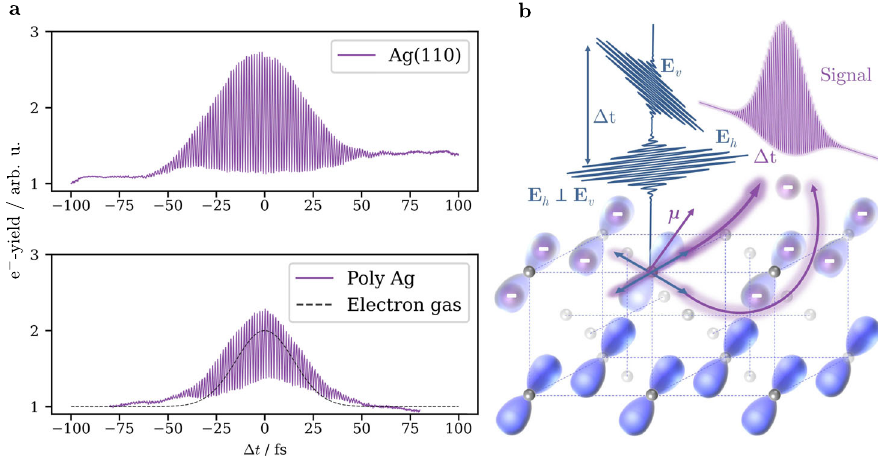
Fig. 1 Cross-polarized two-photon photoemission traces of a Ag(110) and a polycystalline silver surface. a Energy- and momentum-integrated cross- correlation traces on Ag(110) (top) and polycrystalline silver (bottom) showing interference patterns despite the non-interfering pump-probe excitation scheme. The black dashed curve represents the expected behavior in the case of a free electron gas. b Schematic of the coupling between the ! perpendicular electric fi elds and the optical transition dipole μ , which leads to coherent photoexcitation for the fi eld components overlapping with the